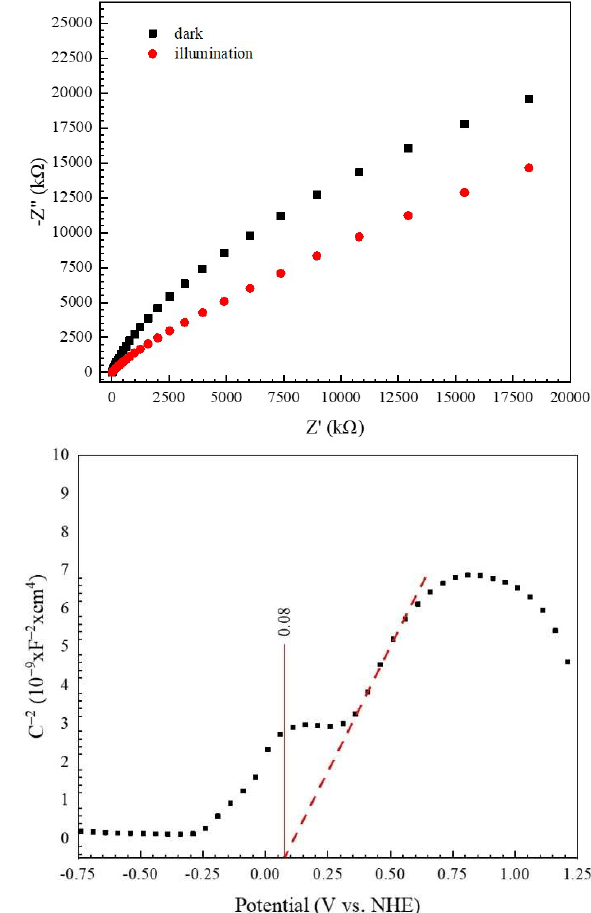
Figure 6. Linear sweep voltammetry scan plots ( a ), electrochemical impedance spectroscopy (EIS) Nyquist plots of the prepared photocatalyst under dark and visible light illumination ( b ), and a Mott-Schottky plot of BiVO 4 ( c ).